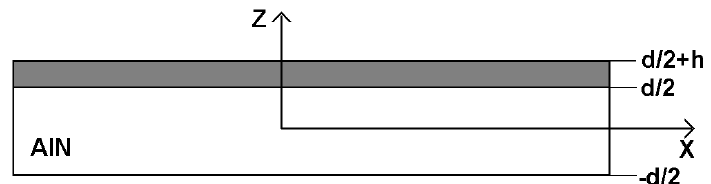
Figure 2. Geometry of the